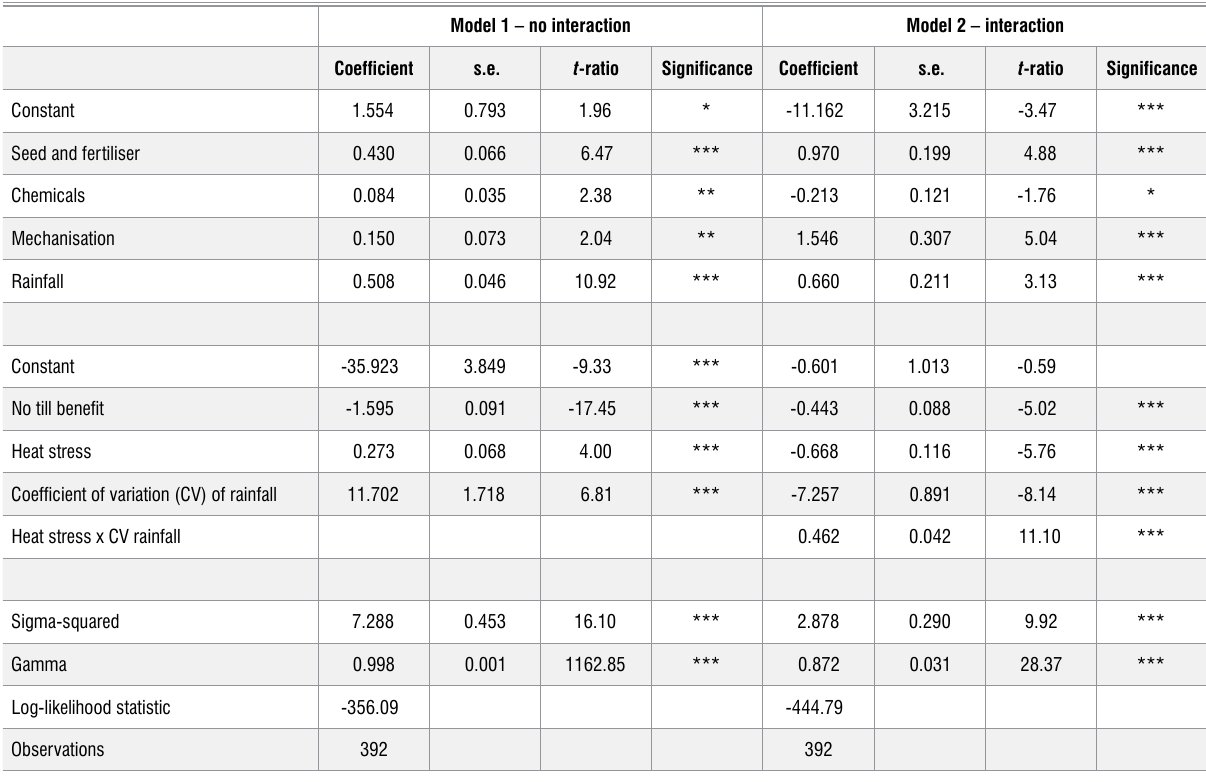
Table 3: Grain productivity model testing the standard deviation of rainfall as drought proxy Model 1 – no interaction Model 2 – interaction